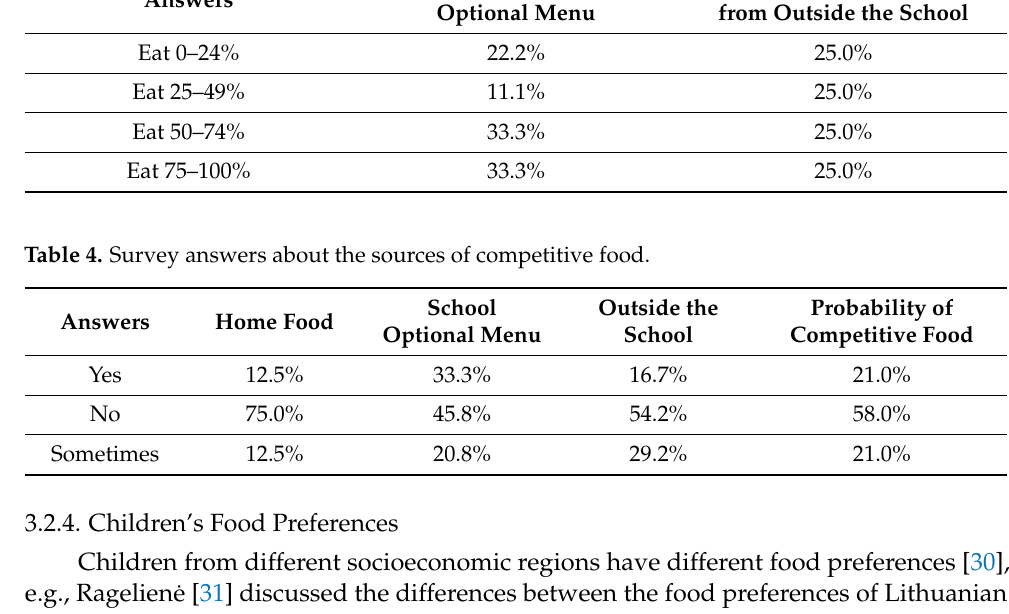
Figure 4. Children’s decisions concerning rejected food. Figure 4. Children's decisions concerning rejected food. Table 3. Survey answers about competitive food impacts on the package menu. Table 3. Survey answers about competitive food impacts on the package menu.